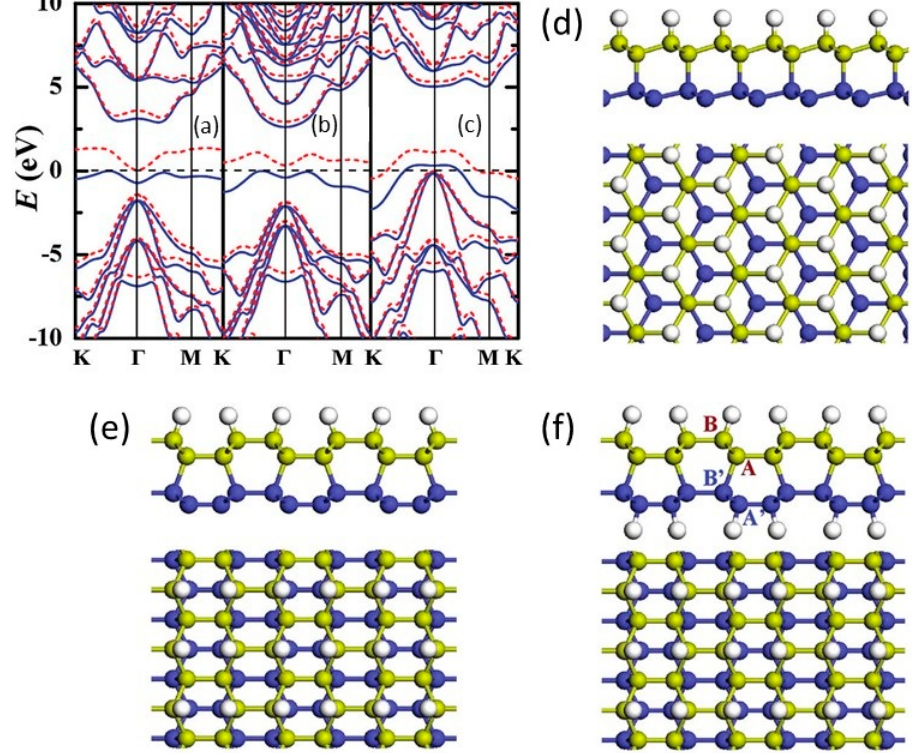
Figure 3. Band structures ( a – c ) of semi-hydrogenated diamane (Don) with lonsdaleite structure ( d ), later named “diamone” [21], with normally applied electric field E: ( a ) − 0.26 V/Å, ( b ) no electric bias and ( c ) 0.39 V/Å (the red and blue curves represent spin-up and spin-down components); semi-hydrogenated diamane Don-L ( e ) and fully hydrogenated diamane Dn-L ( f ) with “boat” structures. C atoms on the top and bottom layers are gold and blue balls, respectively. H atoms are white balls [23].